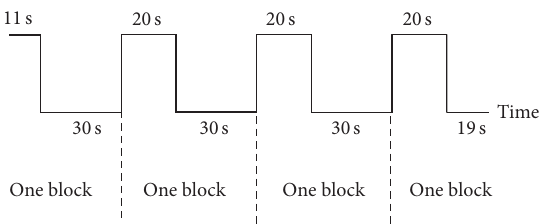
Figure 1: The block design paradigm used in this